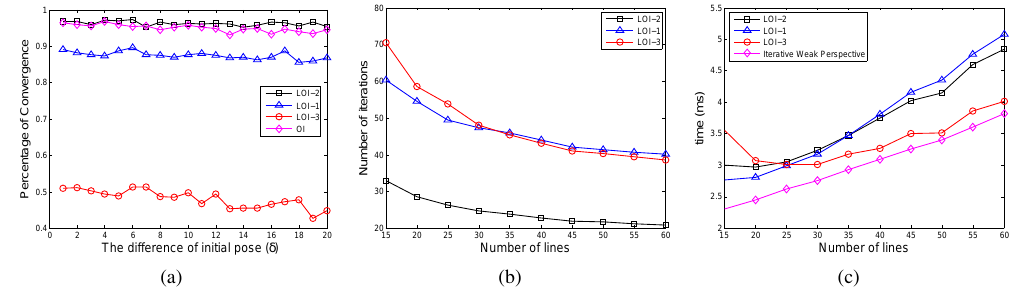
Figure 5: (a) the number of iterations and (b) the running times as a function of the number of lines. (c) the percentage of convergence when initial poses are generated from a multinormal